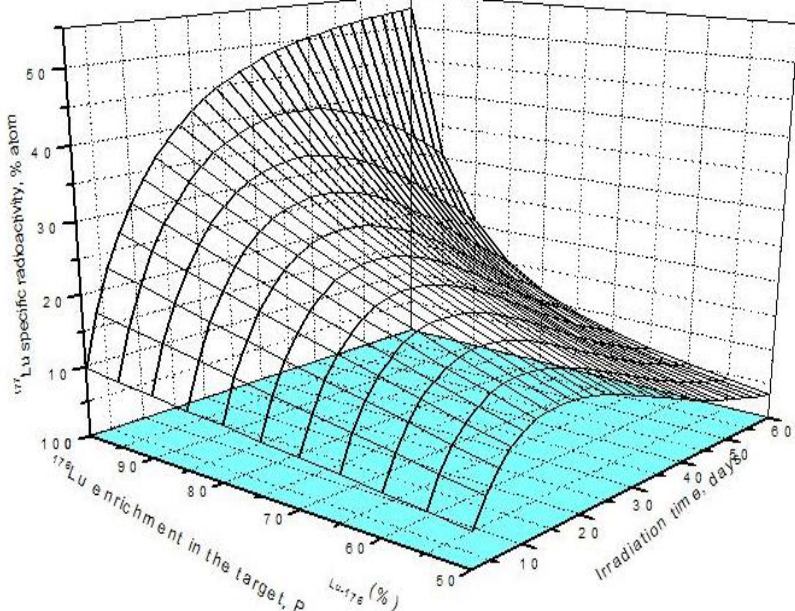
Figure 2 . 177 Lu specific radioactivity as a function of irradiation time and 176 Lu isotopic purity in the target (Thermal neutron flux of 1214 107.1   scmn was applied. Nuclear data was extracted from literatures [11]).